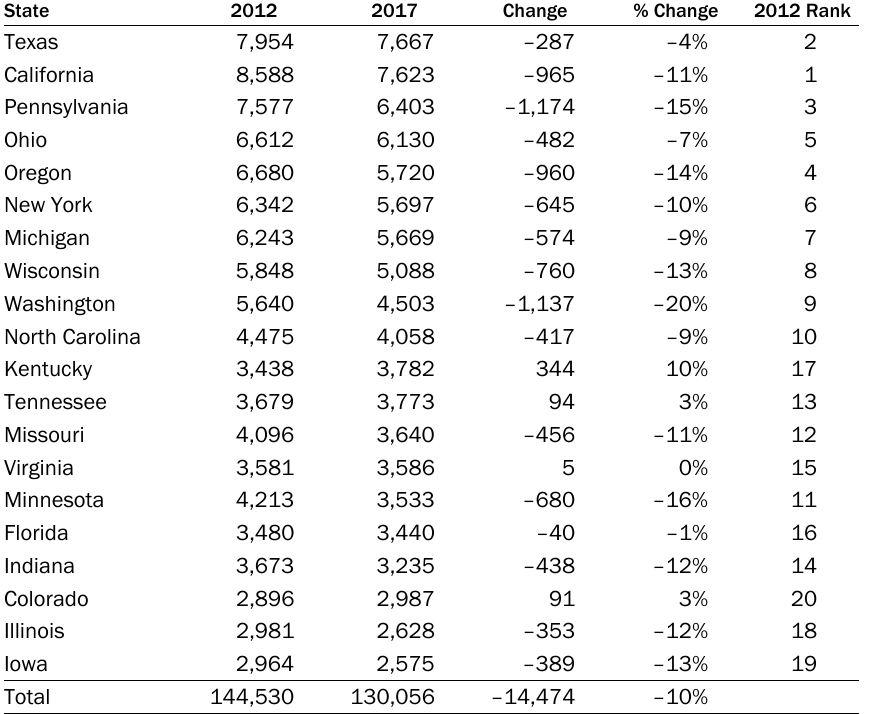
Table 3. Change in Number of Direct-to-Consumer (DTC) Farms, 2012 to 2017, for the 20 States with the Highest Number of DTC Farms in